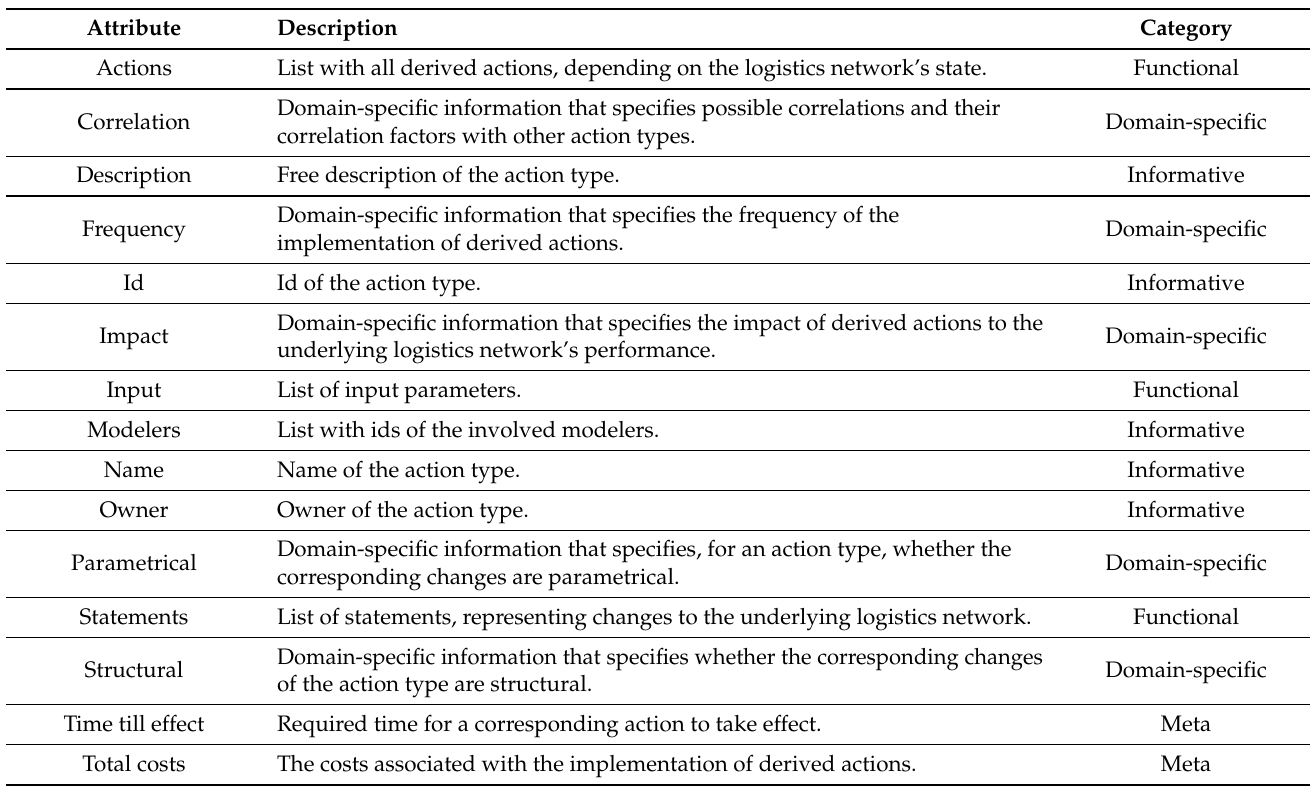
Table 1. The semantic model for action types in wholesale logistics networks, based on Reference